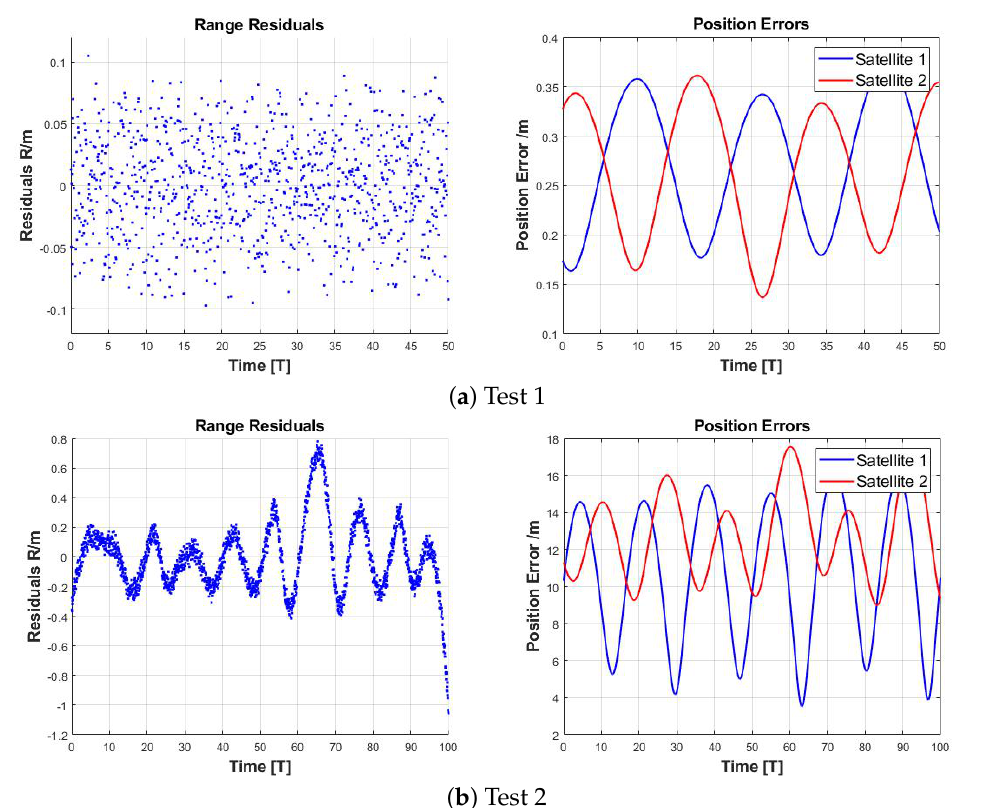
Figure 2. Residual in the observation data ( left ) and norm of the position error of the determined orbit from the true one ( right